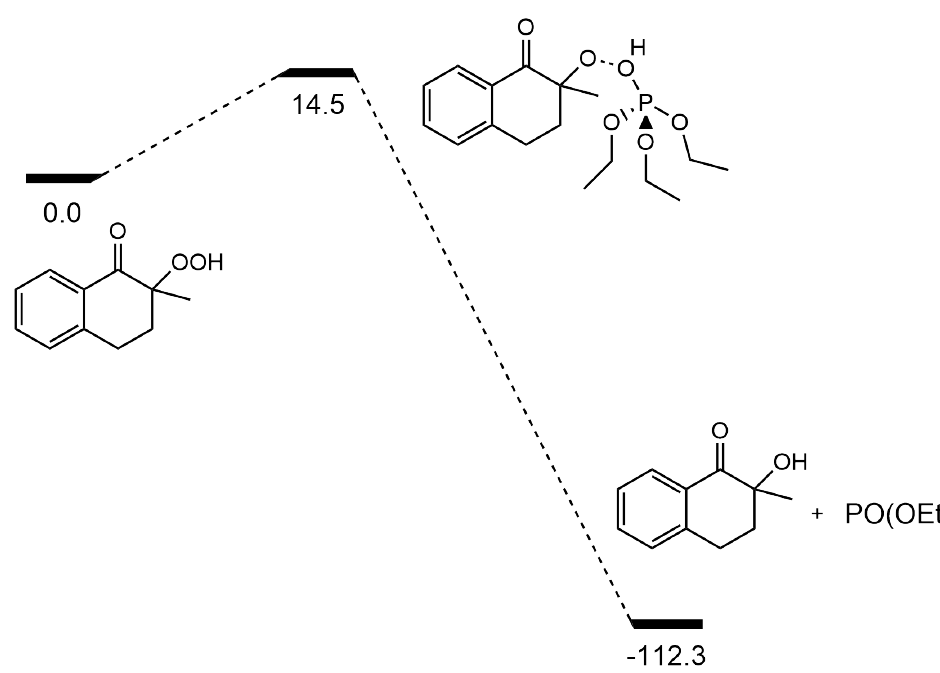
Figure 8. Free energy profile for the reduction of the hydroperoxide to the α − ketol at DLPNO- CCSD(T)/maug-cc-pVTZ//M062X-D3/maug-cc-pVDZ in the ethanol implicit solvent (SMD) level of theory. Energies are given in kcal/mol, and the zero of the energy scale corresponds to the energy of the isolated reactants. Cartesian coordinates of reactants and the transition state are shown in Table